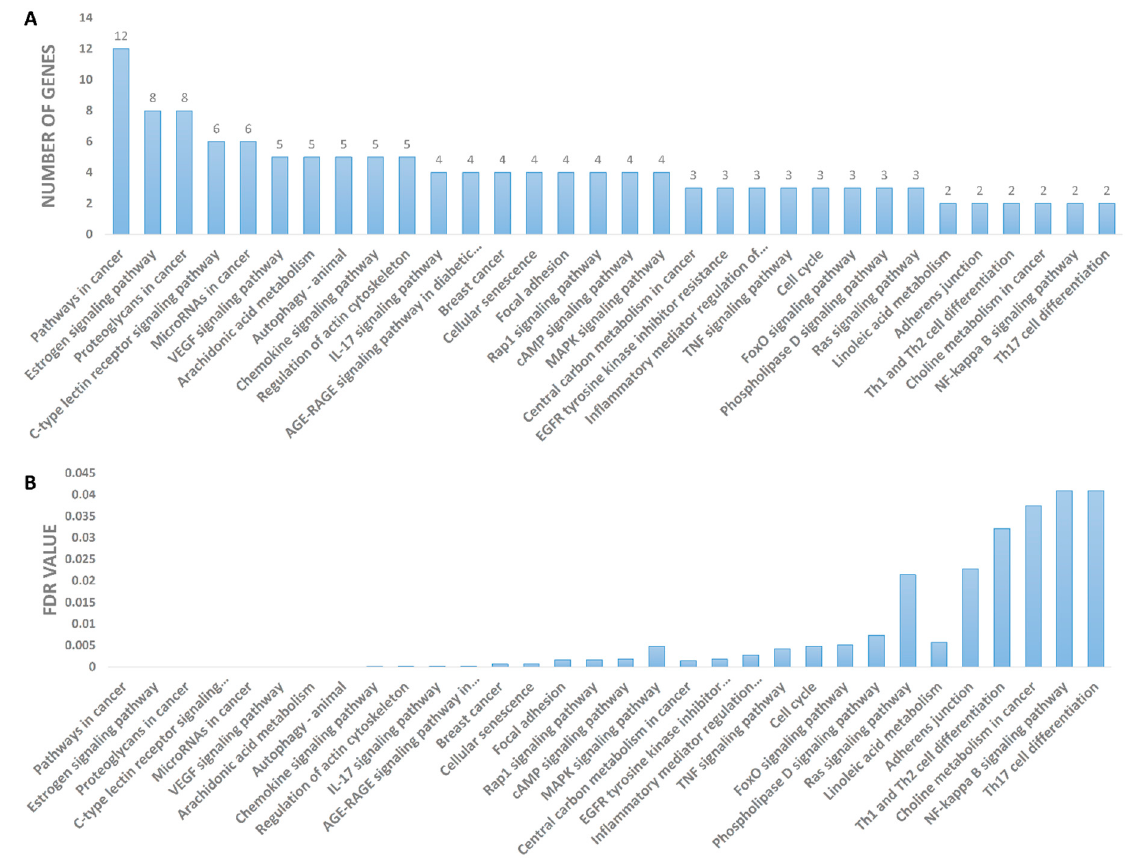
Figure 12. KEGG pathway enrichment. ( A ) X ‐ axis is enrichment gene count, Y ‐ axis is KEGG pathway. ( B ) False discovery rate (FDR) of each annotated pathway.